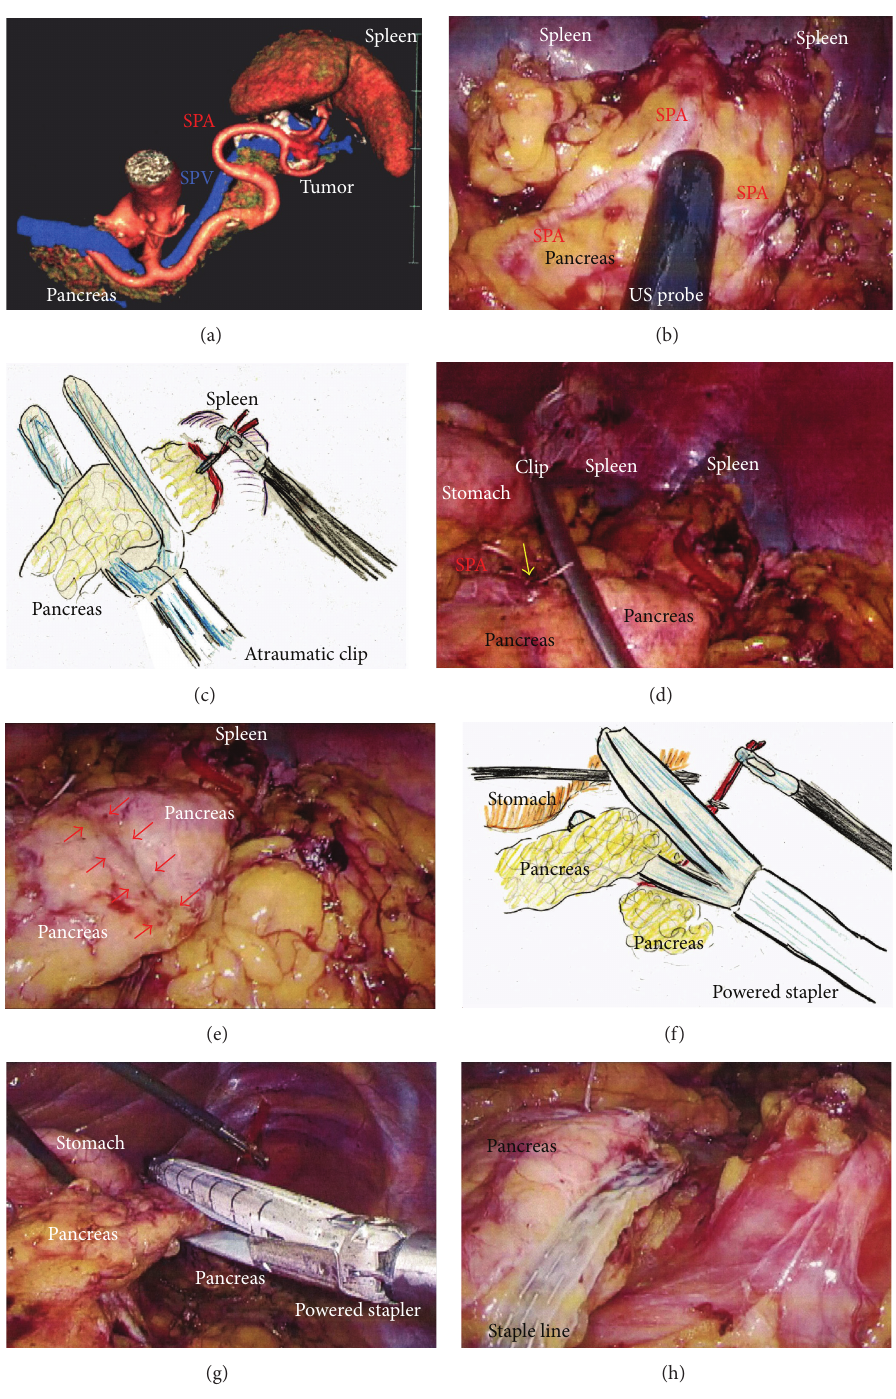
Figure 3: (a) Tumor location and anatomical landmarks were assessed preoperatively. (b) Ultrasound was performed to confirm the tumor location and to determine the cutting line. (c) Compression using an atraumatic clip was required before proceeding further because stapling was performed using a Covidien stapler. (d) The proximal SPA was ligated (yellow arrow) and the pancreas was compressed. (e) Compressed parenchyma was confirmed before proceeding further (red arrows). (f), (g), and (h) The pancreas and SPV were cut en bloc using the powered stapler; the pancreas was retraced with tape. SPA, splenic artery; SPV, splenic